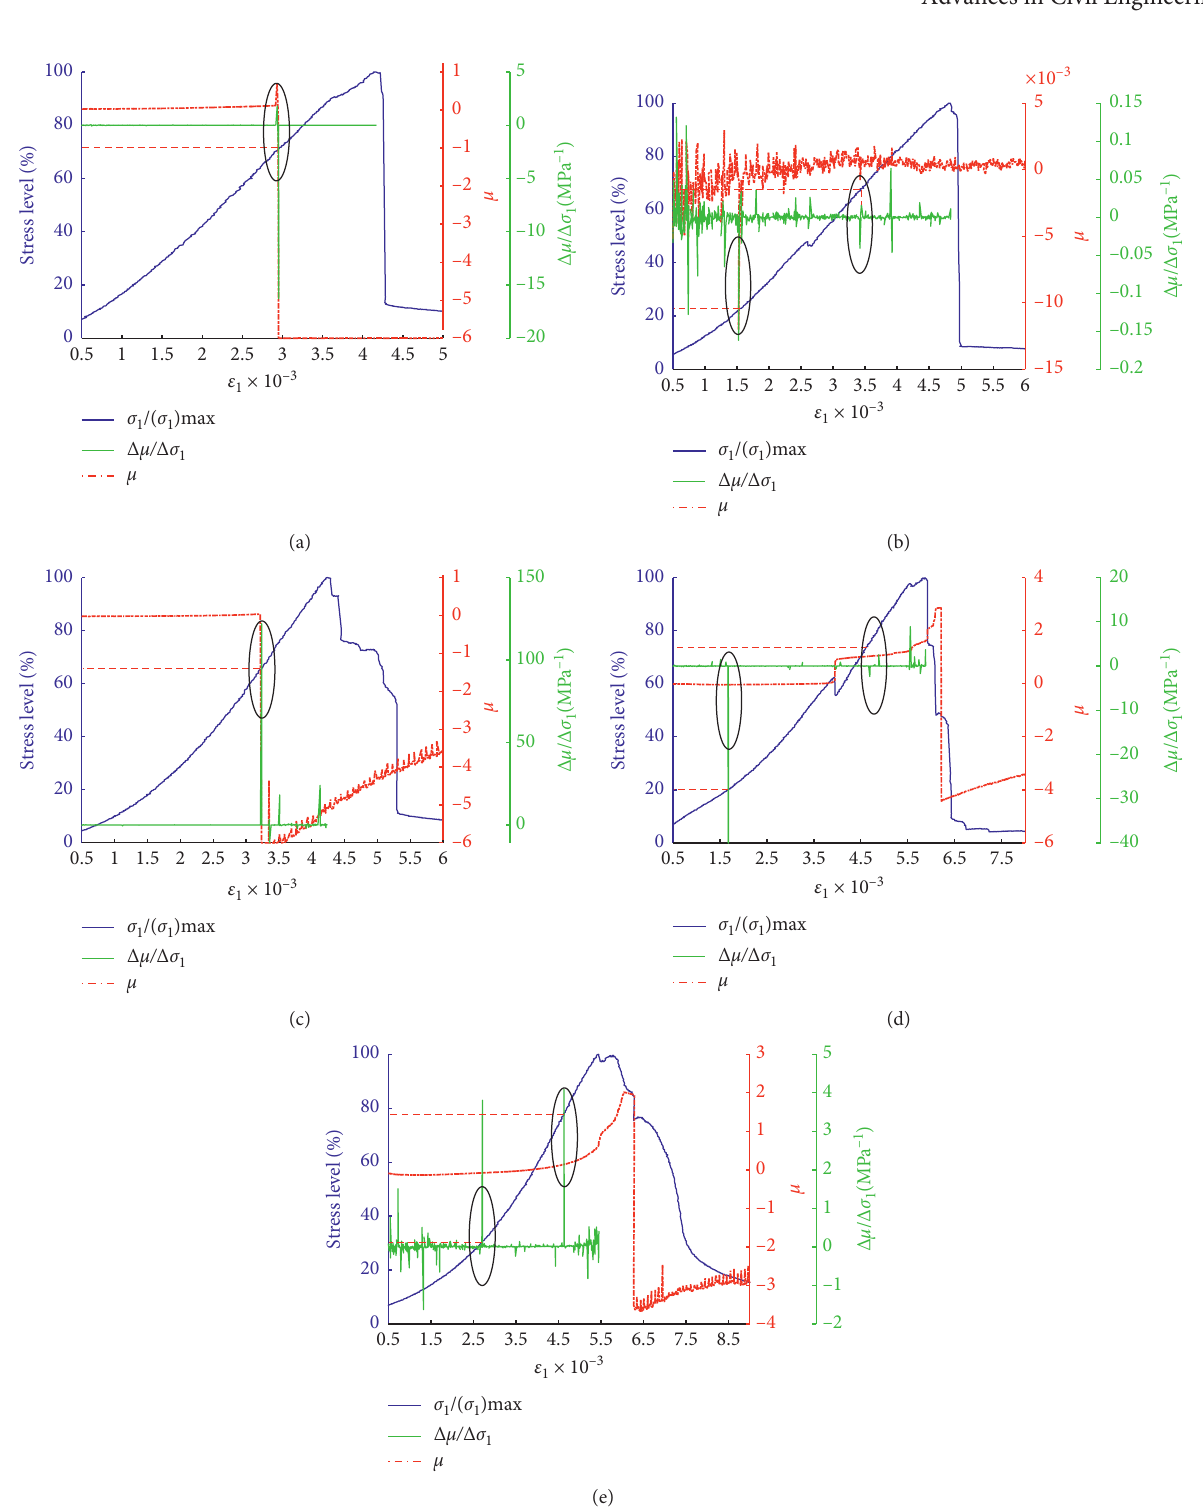
Figure 7: Evolution curve of the increment ratio of Poisson’s ratio to axial pressure. (a) 25 ° C, (b) 200 ° C, (c) 400 ° C, (d) 600 ° C, and (e) 800 °